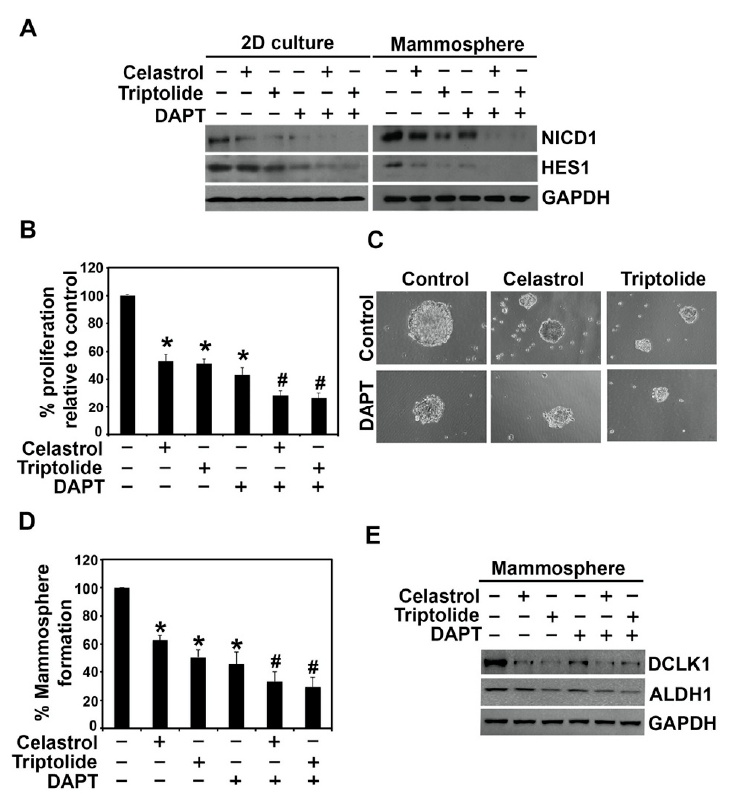
Figure 4. γ -secretase inhibitor, DAPT, altered the celastrol and triptolide-induced suppression of notch signaling in TNBC cells. ( A ) Western blot analysis of BT20 cells treated with DAPT, celastrol, and triptolide for 48 h. NICD1 and HES1 protein expression were suppressed in celastrol and triptolide treatment and further decreased in combination with DAPT. ( B ) Cell proliferation was significantly inhibited following treatment with the compounds and further reduced in combination of DAPT. Each value represents mean ± SD of four separate estimations, n = 3. * p < 0.05 when compared with control; # p < 0.05 when compared with DAPT control. ( C , D ) DAPT treatment alone reduces the mammosphere formation when compared to the control, and a combination with celastrol and triptolide shows further reduction in mammosphere growth. Each value represents mean ± SD of four separate estimations, n = 3. * p < 0.05 when compared with control; # p < 0.05 when compared with DAPT control. ( E ) Expression of stem cell marker proteins DCLK1 and ALDH1 is reduced following DAPT treatment. Combination treatment with celastrol or triptolide further decreases the expression of these proteins in mammospheres.